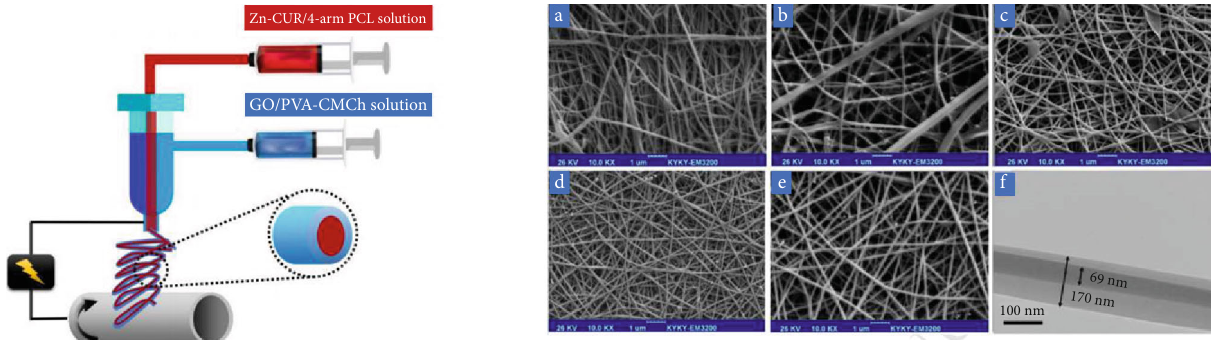
Figure 2: The sca ff olds of coaxial electrospun nano fi bers using GO and Zn-CUR complex for bone regeneration [52] (adopted with